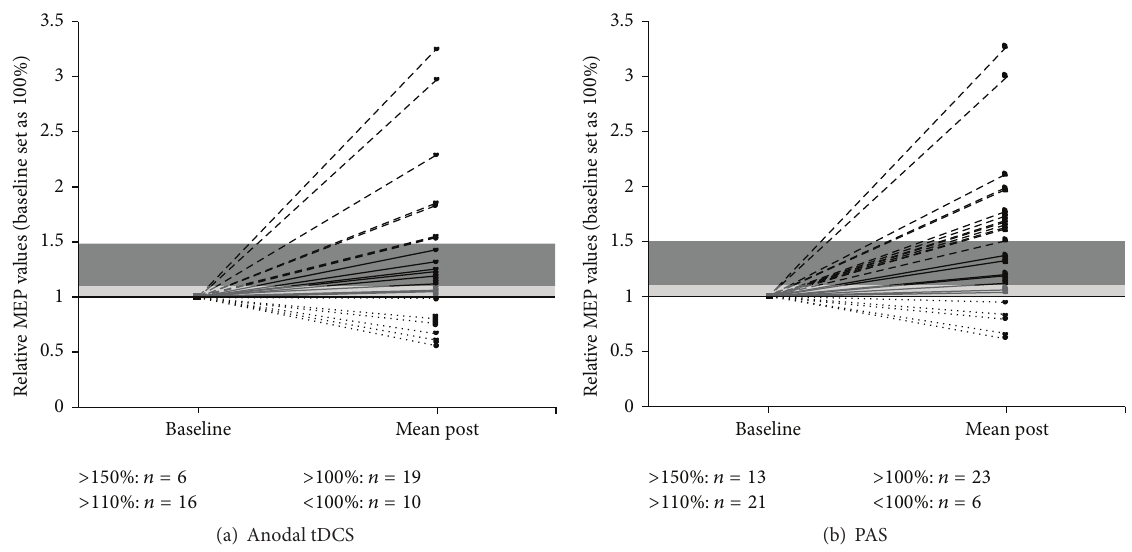
Figure 4: Presentation of the number of responders to (a) anodal tDCS and (b) PAS within the three different response ranges scaled in relative values, with 1 representing 100% of baseline MEP size. The > 100% cut-off range is depicted in light grey and the > 110% range in dark grey. Responders over 150% are shown above the dark grey bar and nonresponders (NR) underneath the black line representing 100% baseline MEP. Total numbers shown for each of the separate cut-off